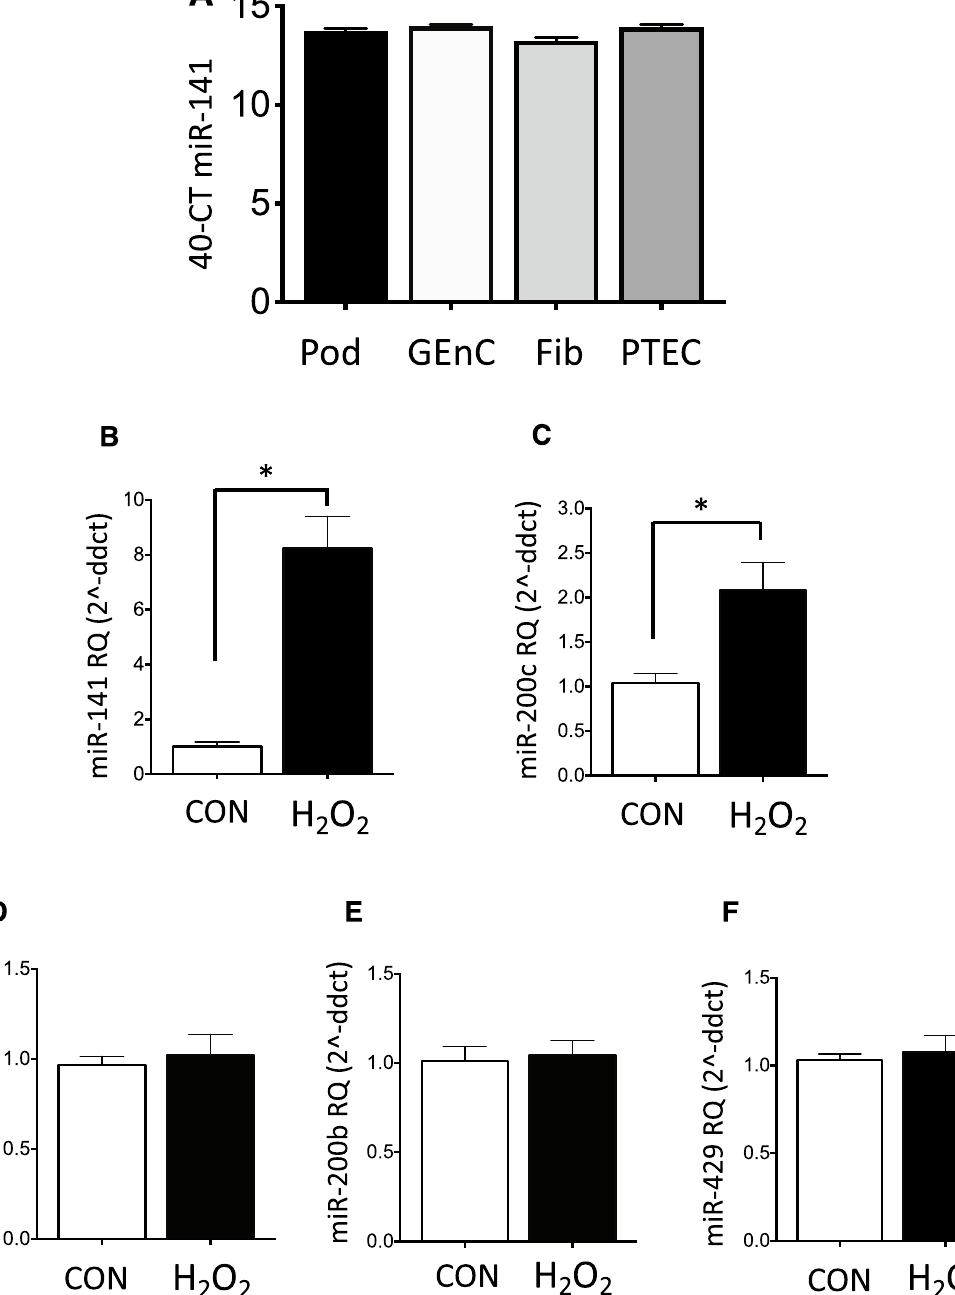
Figure 4. Expression of miR-200 family miRNAs in an in vitro oxidative stress model of AKI. ( A ) RT-qPCR analysis of four cells types found in the kidney: podocytes (Pod), glomerular endothelial cells (GEnC), fibroblasts (Fib) and proximal tubular epithelial cells (PTEC) showed miR-141 detection at similar abundance in each. ( B - F ) RT-qPCR data for miR-200 family expression in an in vitro oxidative stress model of AKI, in which PTECs were treated with 1 mM H 2 O 2 for 24 h. ( B , C ) miR-141 and miR-200c were upregulated under oxidative stress (sevenfold and twofold changes, respectively). ( D - F ) miR-200a, miR-200b and miR-429 showed no significant changes in this model. Statistical analysis comparing H 2 O 2 -treated PTECs with untreated control cells was carried out by unpaired T-test (n = 3). Data were normalised to endogenous control miR-191 and are presented as mean ± SEM; *p <